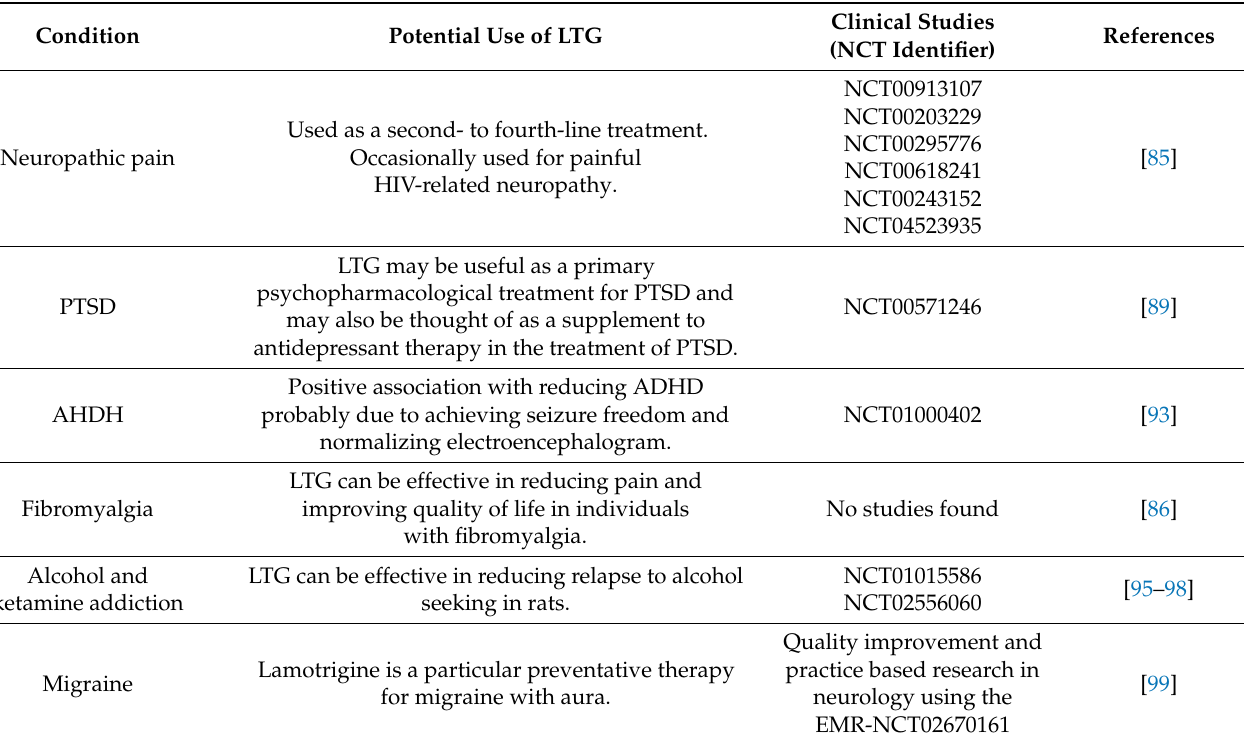
Table 3. Potential uses of LTG for other CNS